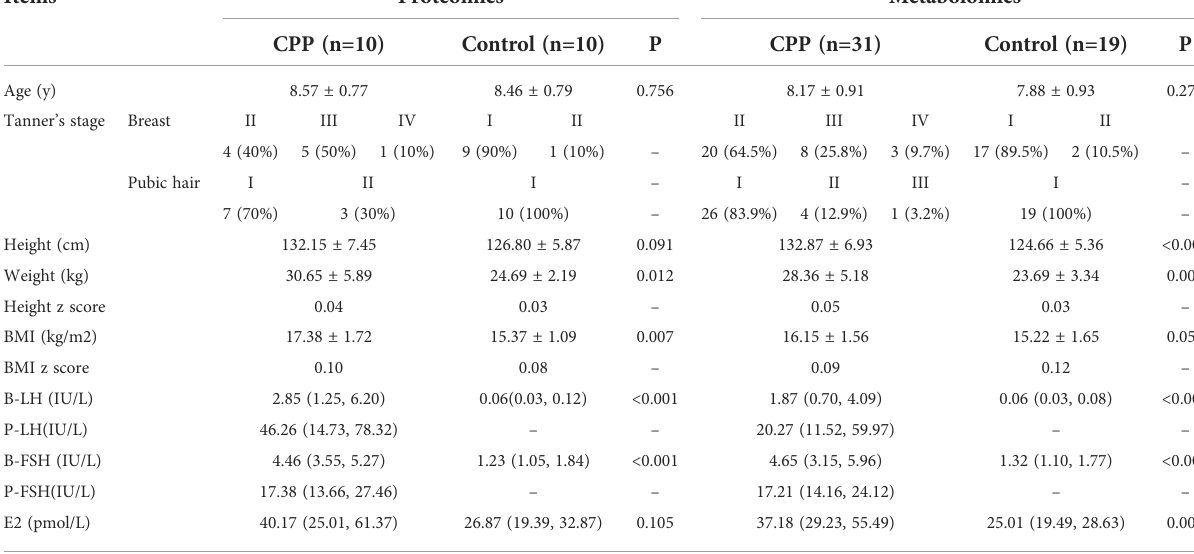
TABLE 1 Anthropometric and hormone characteristics of the research subjects in this